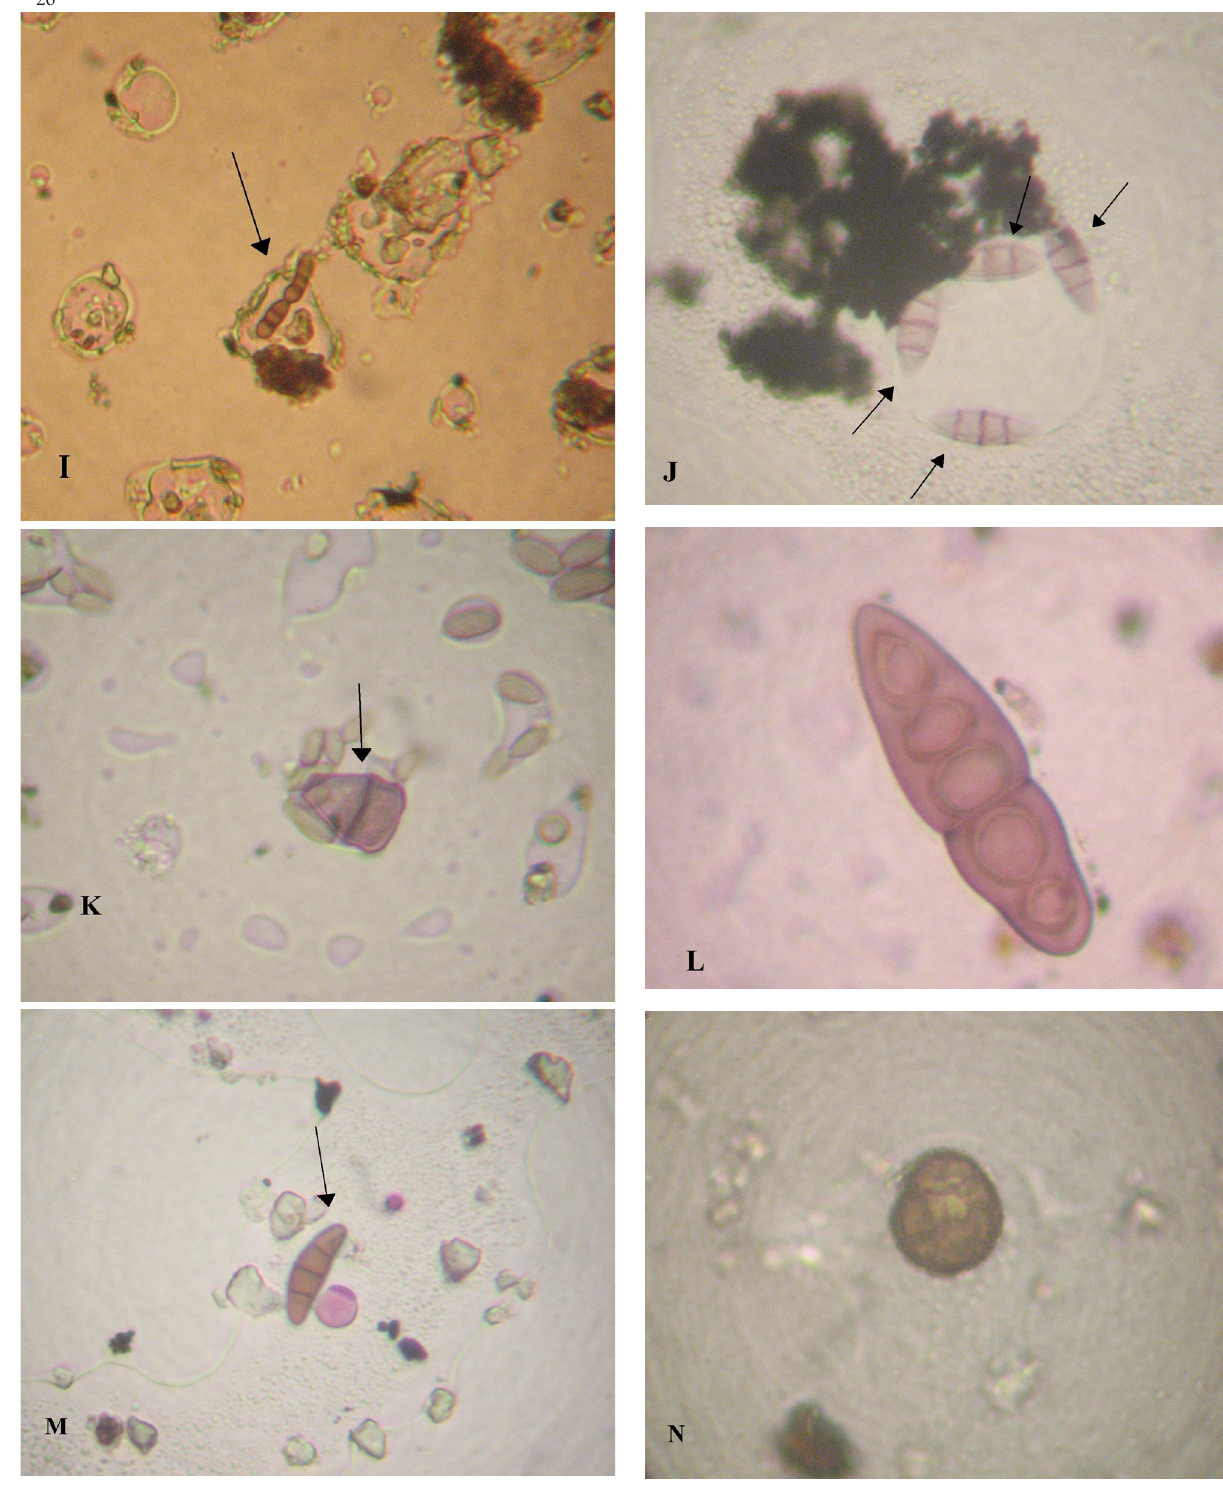
Fig. 2. Airborne fungi detected in Timisoara (A- Alternaria type; B- Drechslera/Helminthosporium type; C- Cladosporium type; D- Nigrospora type; E- Torula type; F- Peronospora type; G- Pithomyces type; H- Stemphylium type; I- Bispora type; J- Capronia type; K- Neohendersonia type; L- Amphisphaeria type; M- Fusarium/Leptosphaeria type; N- Epicoccum